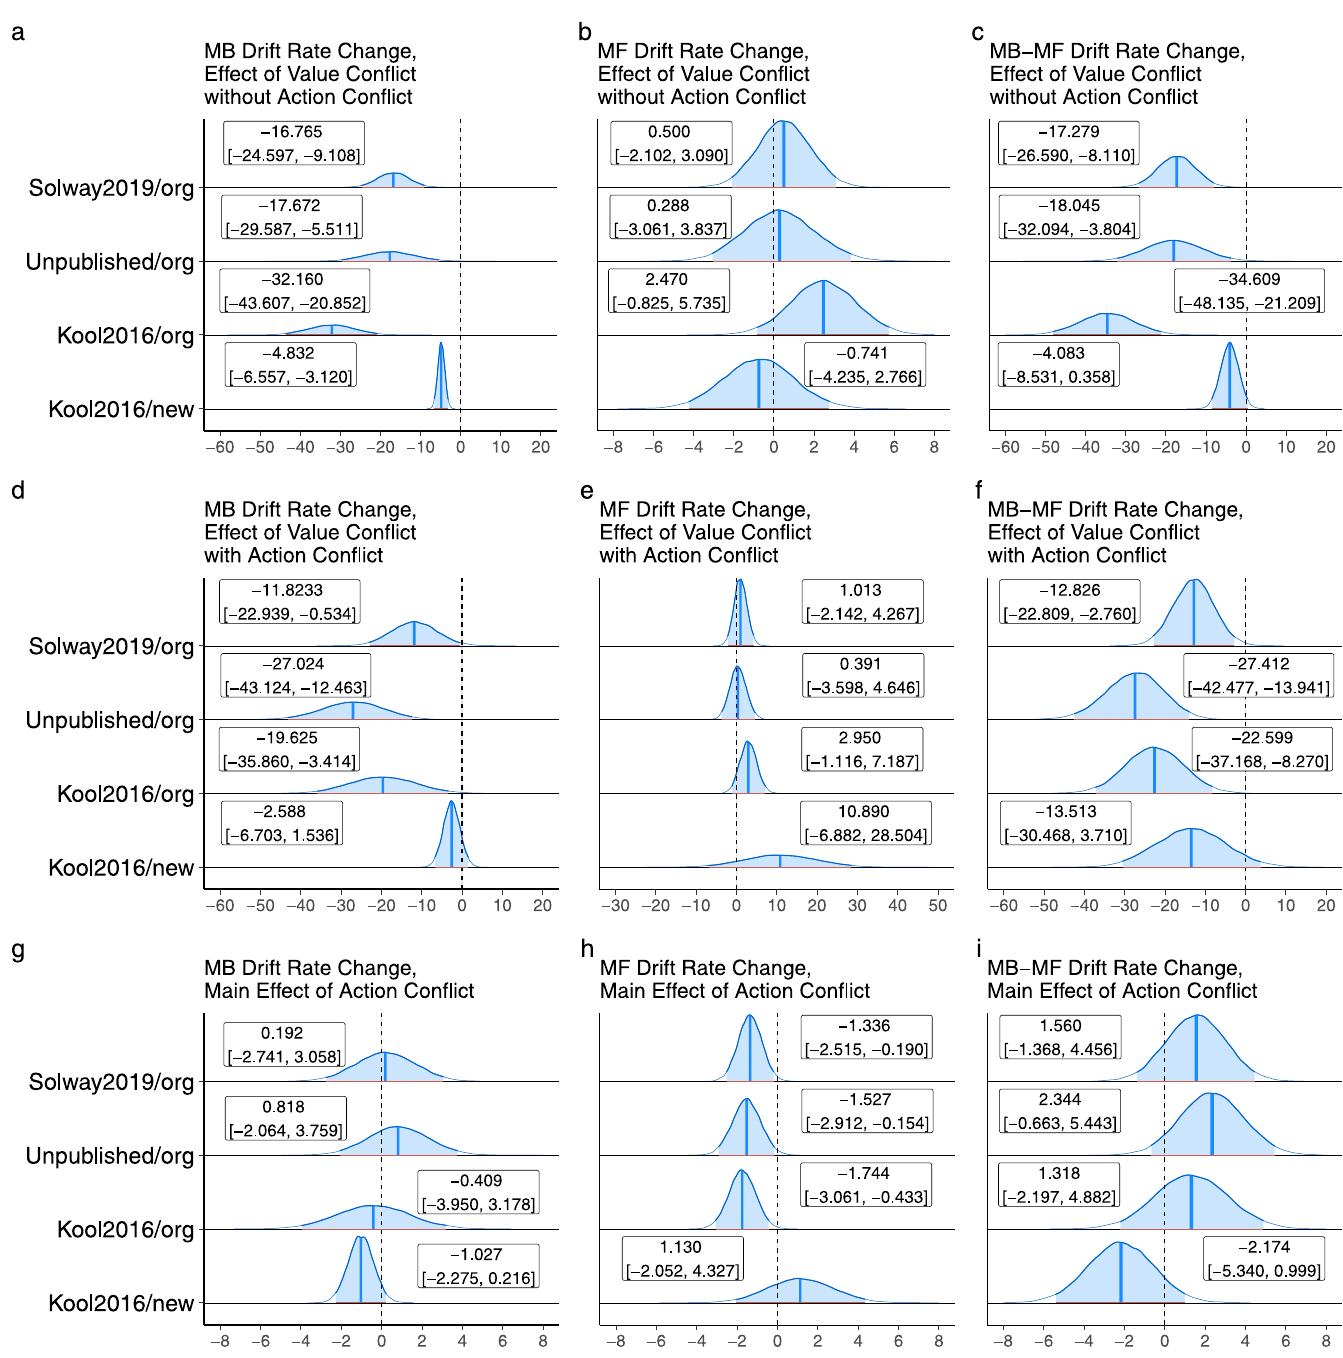
Fig 2. First row: The effect of value conflict in the absence of action conflict on the strength of model-based and model-free control in all four datasets. Second row: The same as the first row, but for trials with action conflict. Third row: Main effect of action conflict on model-based and model-free control.